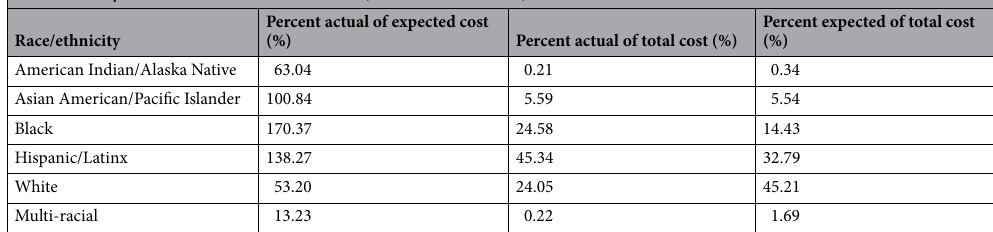
Table 4. Racial breakdown of actual and expected economic costs of COVID-19 deaths in Harris County. “Percent Expected of Total Cost” assumes uniform deaths across races/ethnicities and age